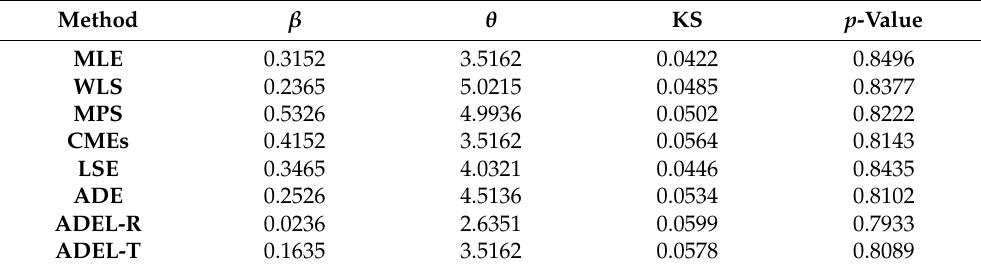
Table 10. Different parameter estimators with glass fiber